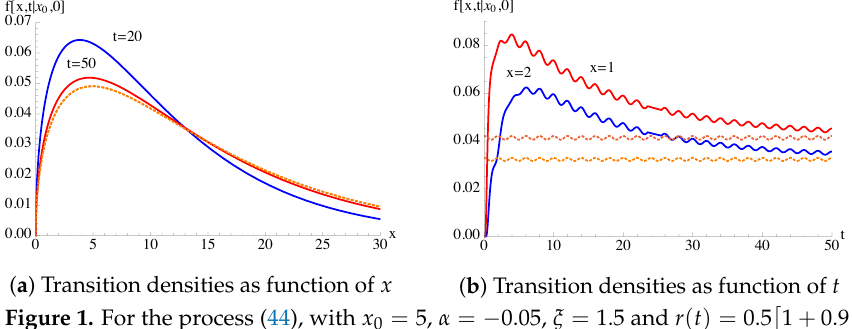
(cid:2) (cid:0) (cid:1)(cid:3) π t 1 + 0.9 sin , the